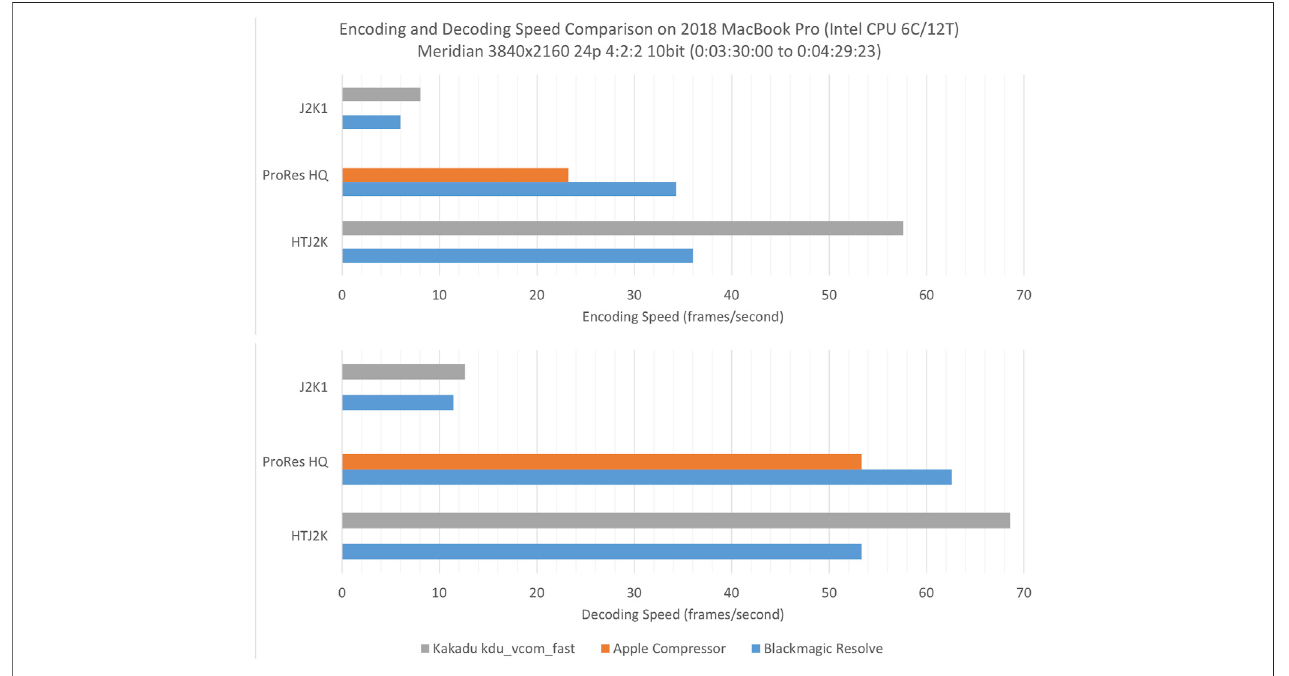
FIGURE 9 | Encoding and decoding speed test results.